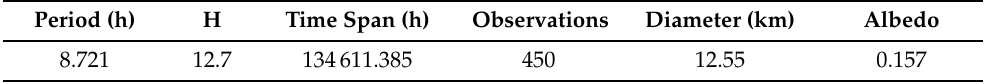
Table 4. Median value of each parameter for asteroids in DAMIT